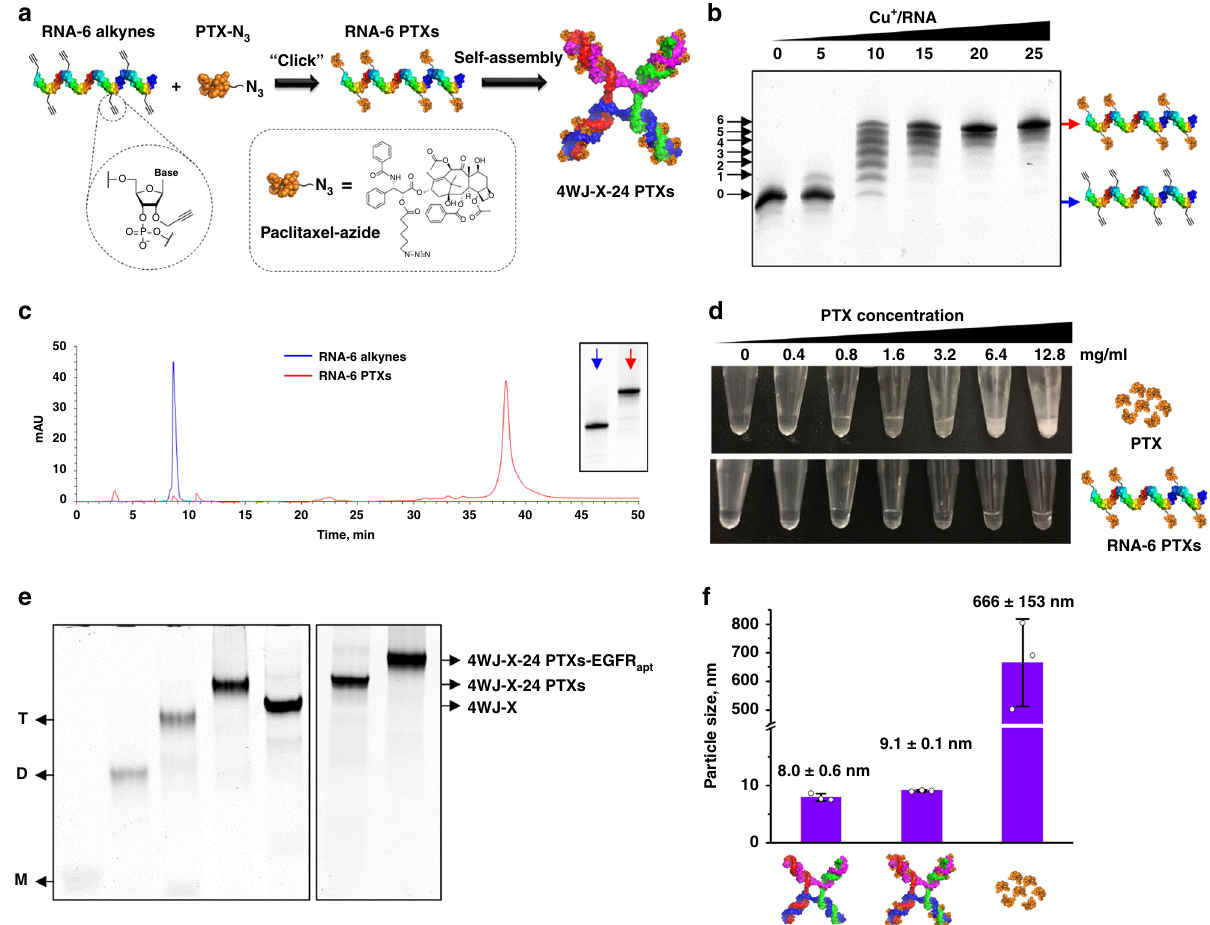
Fig. 2 Conjugation of RNA-PTX and construction of 4WJ-X-24 PTXs nanoparticles. a Schematic of RNA-6 PTXs chemical conjugation and 4WJ-X-24 PTXs self-assembly. b Conjugating six PTXs to an RNA, evaluated by denaturing PAGE. c HPLC chromatogram (absorbance 260 nm) with an inserted gel image of RNA-6 alkynes (blue) and RNA-6 PTXs (red). d Turbidity changes of PTX and RNA-6 PTXs in aqueous solution at two-fold serial dilution. e Step-wise self-assembly of 4WJ-X-24 PTXs and 4WJ-X-24 PTXs-EGFR apt , evaluated by native PAGE (M, D, and T indicate RNA monomer, dimer, and trimer conjugated with PTX, respectively). f Size comparison of 4WJ-X, 4WJ-X-24 PTXs, and PTX in aqueous solution by DLS ( n = 3 independent samples, mean ± SD). Source data are provided as a Source Data fi